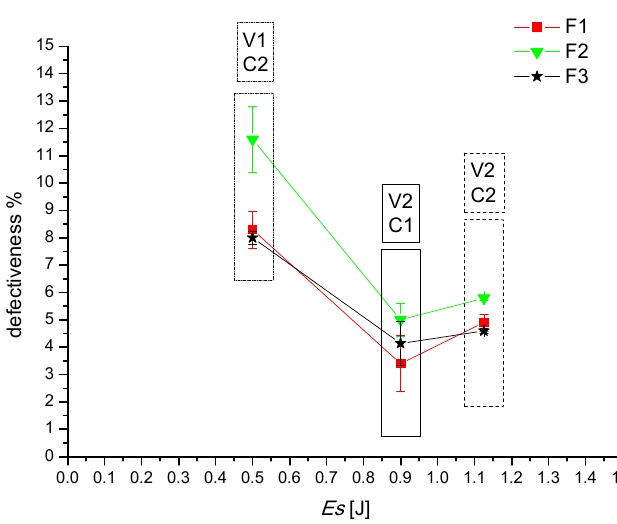
Figure 13. Percentage defectiveness in deposits cross-section as a function of spark pulse-energy ( Es ) for three values of frequency (F1 < F2 < F3).